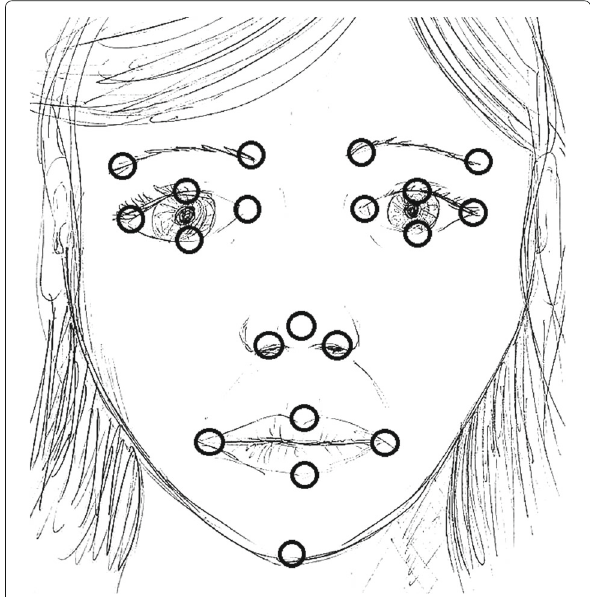
Fig. 6 Face points. The 20 face points used as features for laughter-speech classification of MAHNOB Laughter dataset videos